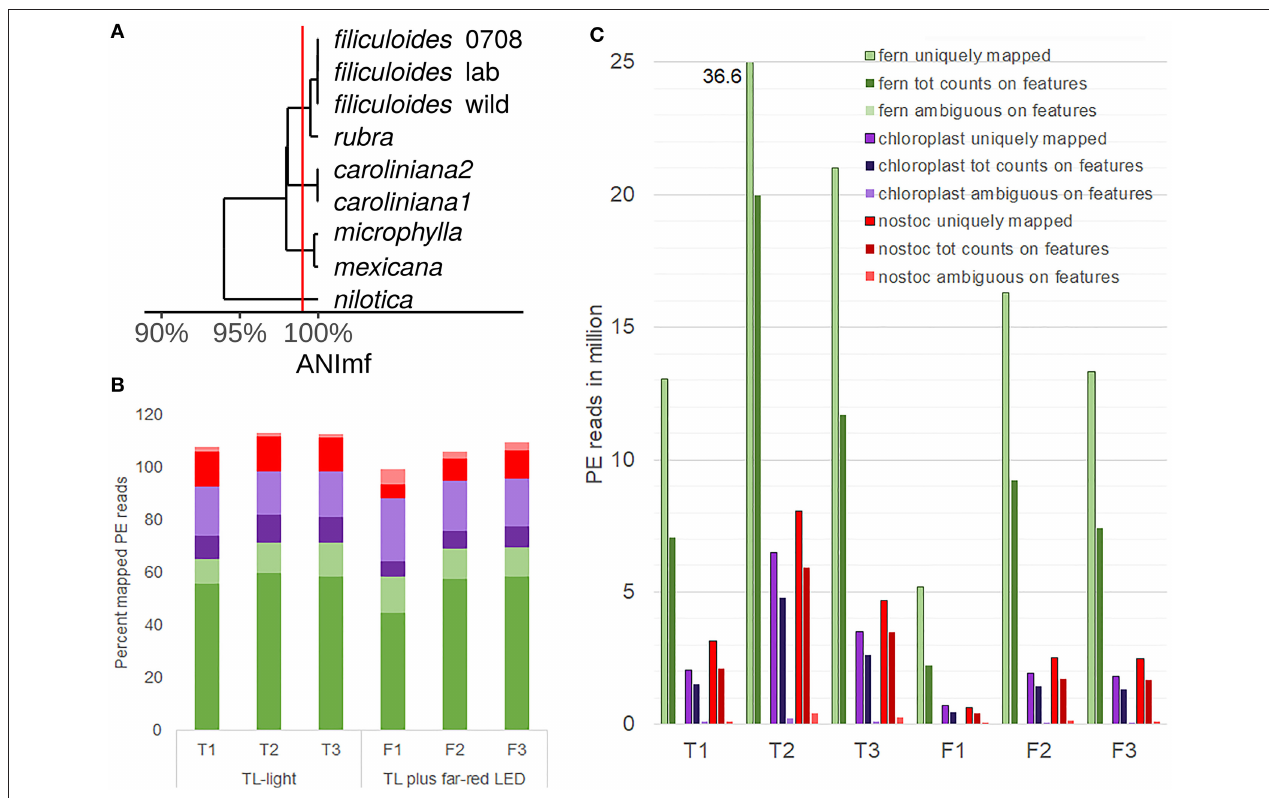
FIGURE 4 | Profiling eukaryotic and prokaryotic RNA simultaneously in A. filiculoides [dual RNA - sequencing (RNA-seq)]. (A), Similarity of the N. azollae 0708 genome and metagenome assembled genomes (MAGs) from N. azollae strains in Azolla species. Average nucleotide identity (ANI) was calculated with the dRep implementation of nucmer using the ANImf preset ( Kurtz et al., 2004; Olm et al., 2017). Pairwise average ANI is shown in an UPGMA dendrogram (Wickham, 2011; de Vries and Ripley, 2016). Aligned MAGS covered over 90% of the reference N. azollae 0708. (B) Proportion (percent) of uniquely aligned paired-end (PE) reads (dark color) and PE reads aligned at multiple loci (light color) on the genomes of fern (green), fern chloroplast (purple), and N. azollae 0708 (red). PE reads were from the samples of sporophytes grown for 1 week on TL light (replicates T1, T2, and T3) or TL light with FR (replicates F1, F2, and F3). STAR-aligner was used in PE mode. (C) Yields of PE uniquely mapped were compared with PE read counts on features and PE reads that STAR was aligned ambiguously to several features. Features were specified by current general features files of each of the fern (green), chloroplast (purple), and N. azollae 0708 (red)